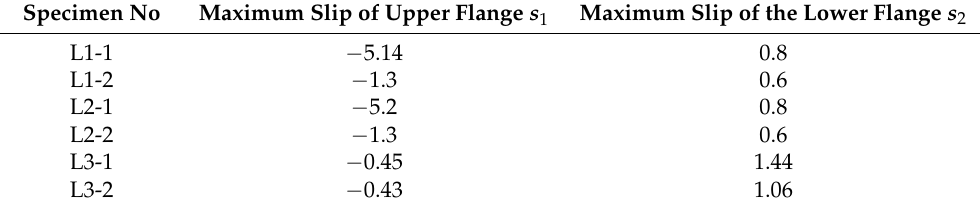
Table 6. Relative slip values for TSC